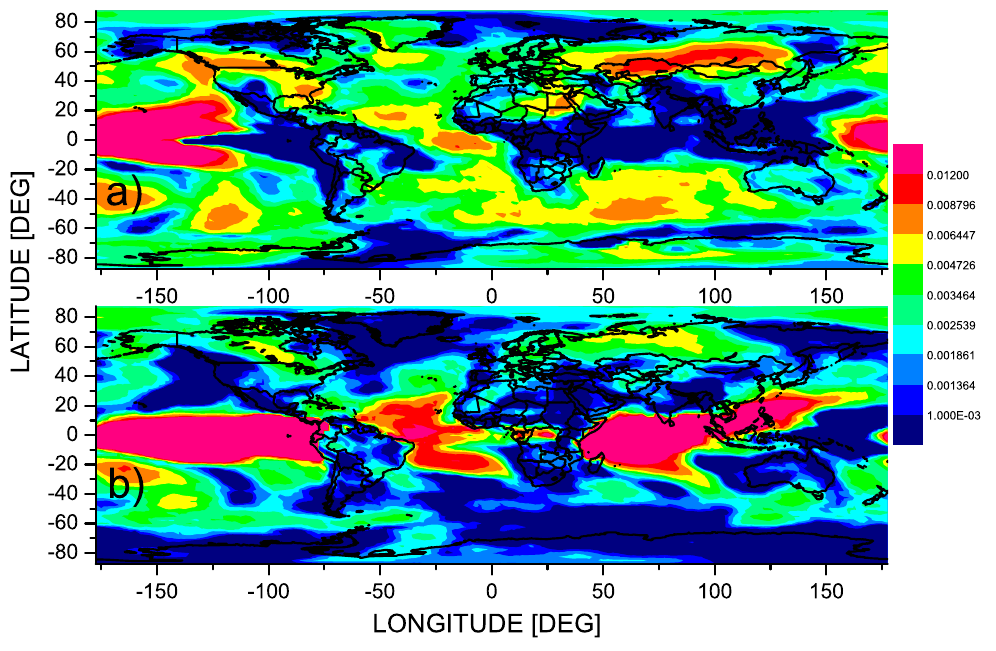
Fig. 7. Area weighted connectivity for SATA climate networks with density % = 0 . 005 obtained by uniform thresholding of the absolute correlations for negative (a) and positive (b) ENSO index.